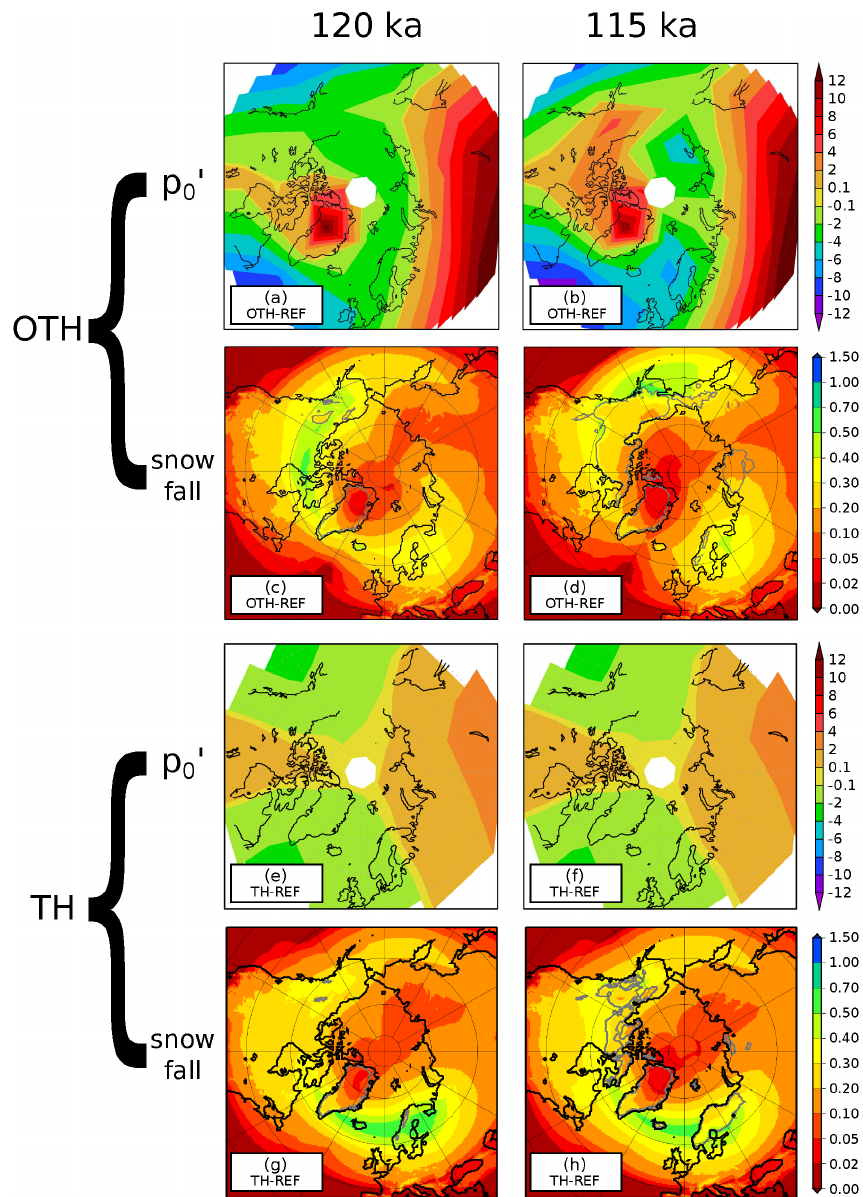
Fig. 6. Azonal sea-level pressure (in hPa) at 120 and 115ka for OTH (a–b) and TH experiments (e–f) , respectively, and accumulation (in meter water equivalent) at 120 and 115ka for OTH (c–d) and TH experiments (g-h) . Grey lines indicate the limits of the ice